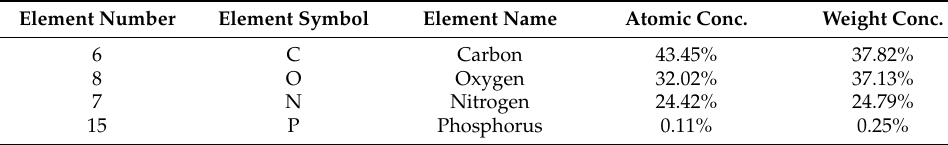
Table 2. EDS elemental analysis of SF/PLGA/BP@SF-4